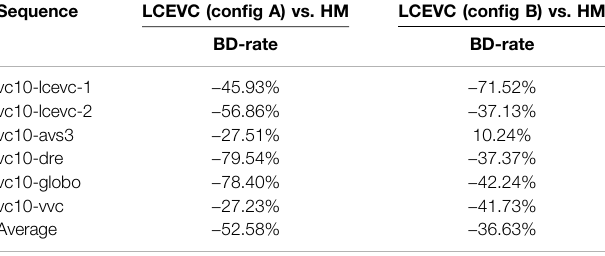
TABLE 1 | MOS scores and CI for PQ sequences. Sequence